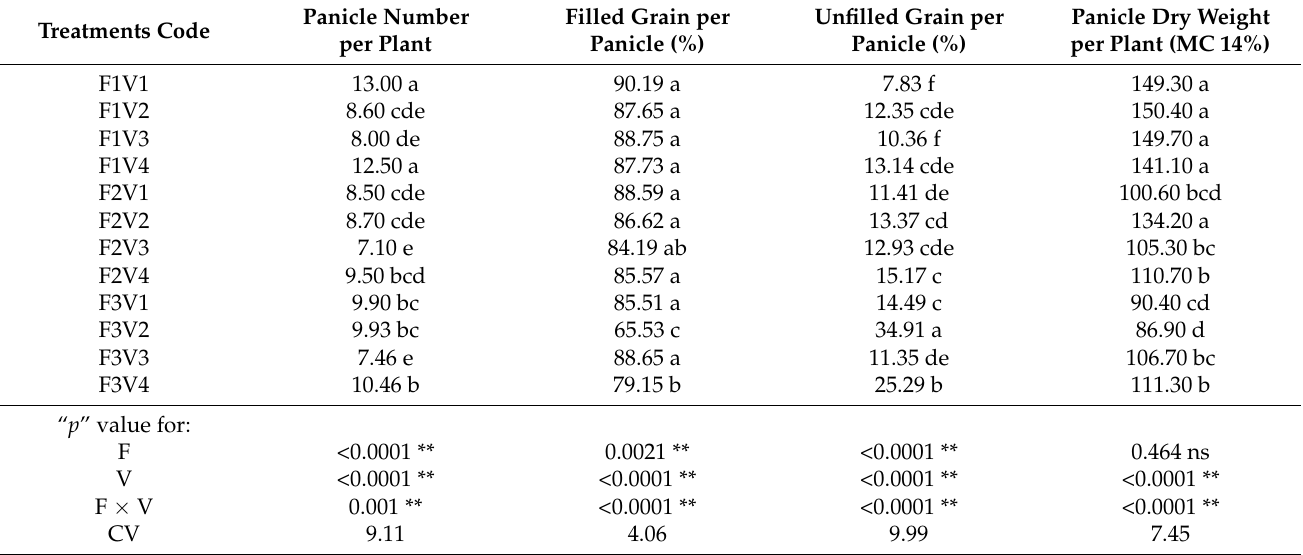
Table 6. Panicle number per plant, filled grain per panicle, unfilled grain per plant, and panicle dry weight per plant of the study in karst dryland, in Gunungkidul, WS